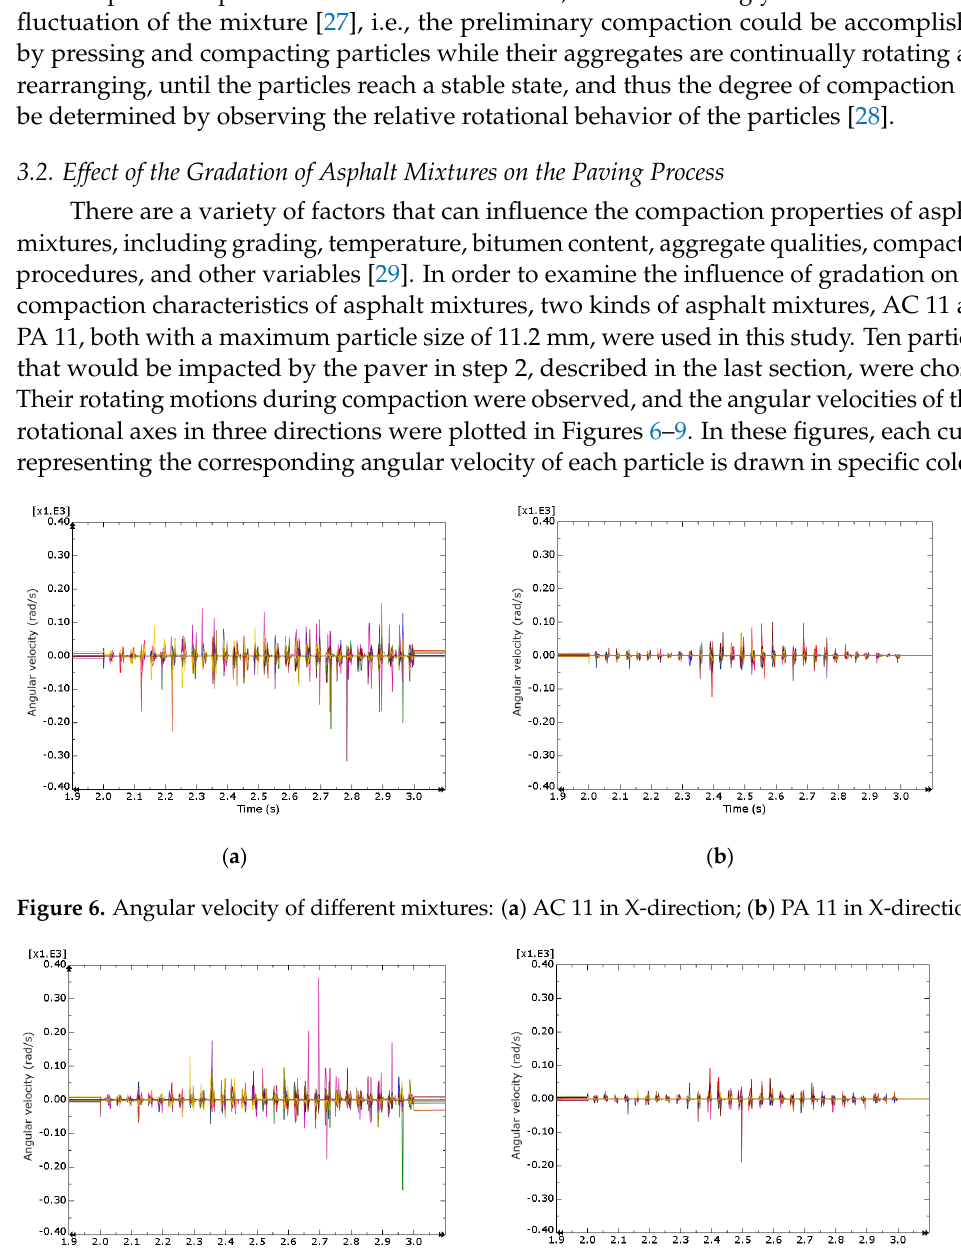
Figure 7. Angular velocity of different mixtures: ( a ) AC 11 in Y-direction; ( b ) PA 11 in